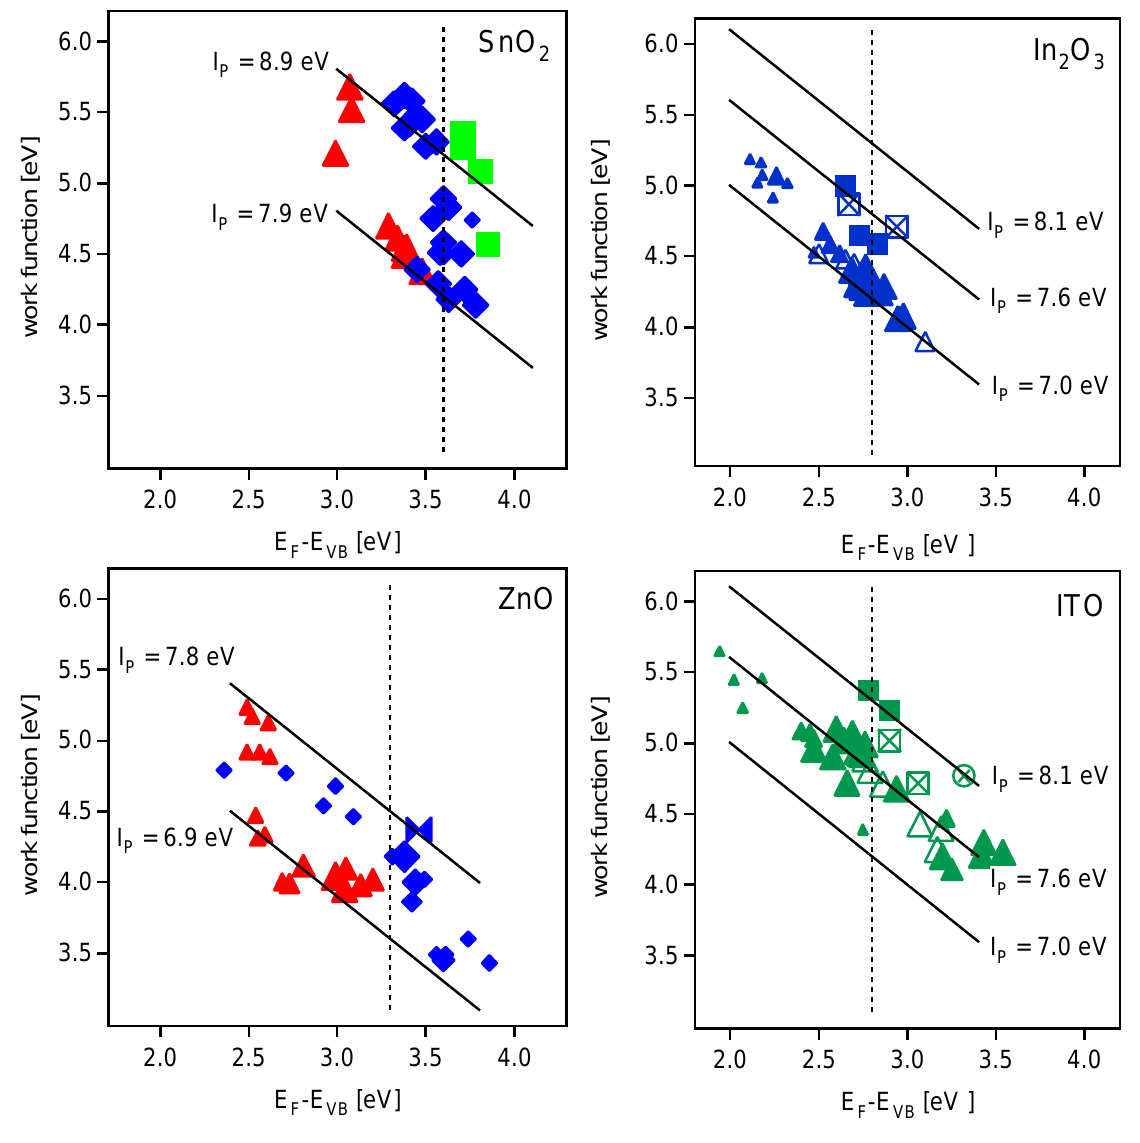
Figure 2. Work function versus Fermi level position plots. Solid lines follow constant ionization potentials, dotted vertical lines mark the intrinsic bandgap, and symbol size corresponds to substrate temperature during deposition (smallest = room temperature, largest = 400 ◦ C ( 500 ◦ C for (b)). (a) upper left graph RF magnetron sputtered SnO (triangles) and SnO :Sb (diamonds) grown at 400 ◦ C, and sintered ceramic SnO 2 (squares); (b) lower left graph DC magnetron sputtered ZnO (triangles) and ZnO:Al (diamonds) thin films, and sintered ceramic ZnO:Al (bowtie); (c) upper right graph In reactively evaporated (open triangles), RF magnetron sputtered (closed triangles), sintered (filled squares), and air-annealed (crossed squares); (d) lower right ITO sintered ceramic samples (filled squares), air-annealed thin films (crossed squares), ozone-trated thin films (crossed circle), and RF magnetron sputtered 2% doped ITO (open triangles) and 10% doped ITO (filled